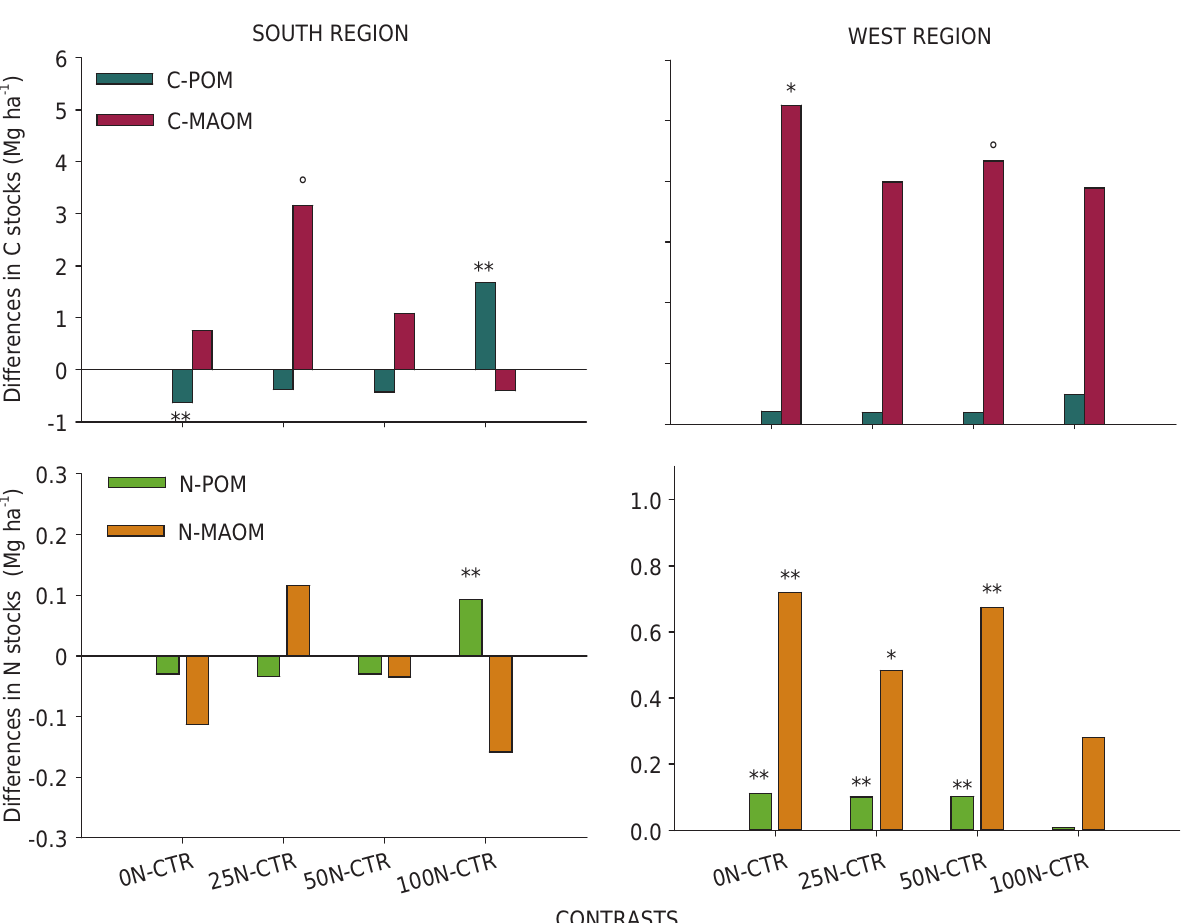
Figure 1. Contrasts of final C and N stocks (Mg ha -1 ) in particulate organic matter (POM) and mineral-associated organic matter (MAOM) in the 0.00-0.10 m soil layer. 0N-CTR: effect of residue addition; 25N-CTR: effect of residue and 25 kg ha -1 of N addition; 50N-CTR: effect of residue and 50 kg ha -1 of N addition; 100N-CTR: effect of residue and 100 kg ha -1 of N addition. °, *, and **: significant contrasts at 10, 5, and 1 %, respectively, by the Dunnett